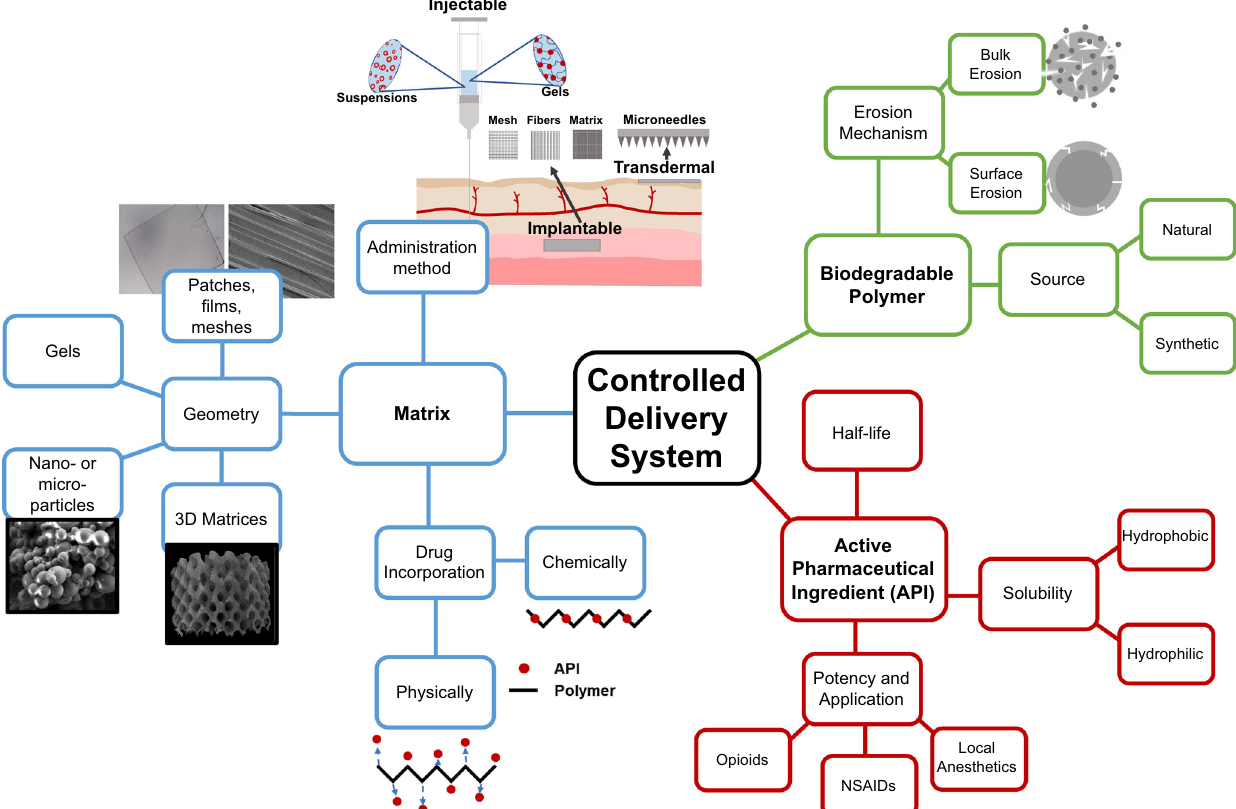
Fig. 3 Polymeric drug delivery systems afford many different size scales due to the fl exibility in processing of synthetic polymers. Each scale class offers it ’ s own bene fi ts and application methods that prove useful for targeting speci fi c types of